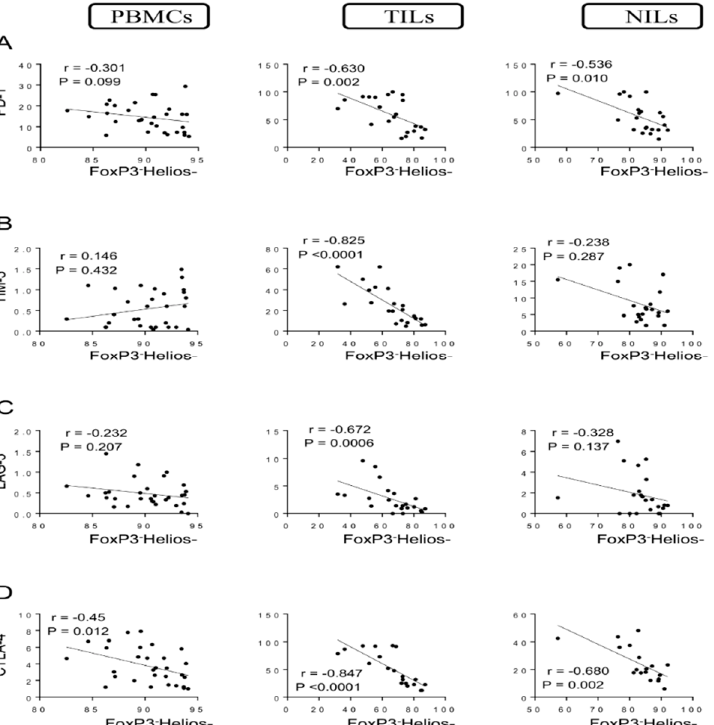
Figure 6. Correlations between levels of FoxP3 − Helios − and immune checkpoints in CD4 + T cells in CRC patients. Correlation between levels of CD4 + FoxP3 − Helios − T cells with PD-1 + ( A ), TIM-3 + ( B ), LAG-3 + ( C ), and CTLA-4 + ( D ) in PBMCs, TILs, and NILs .